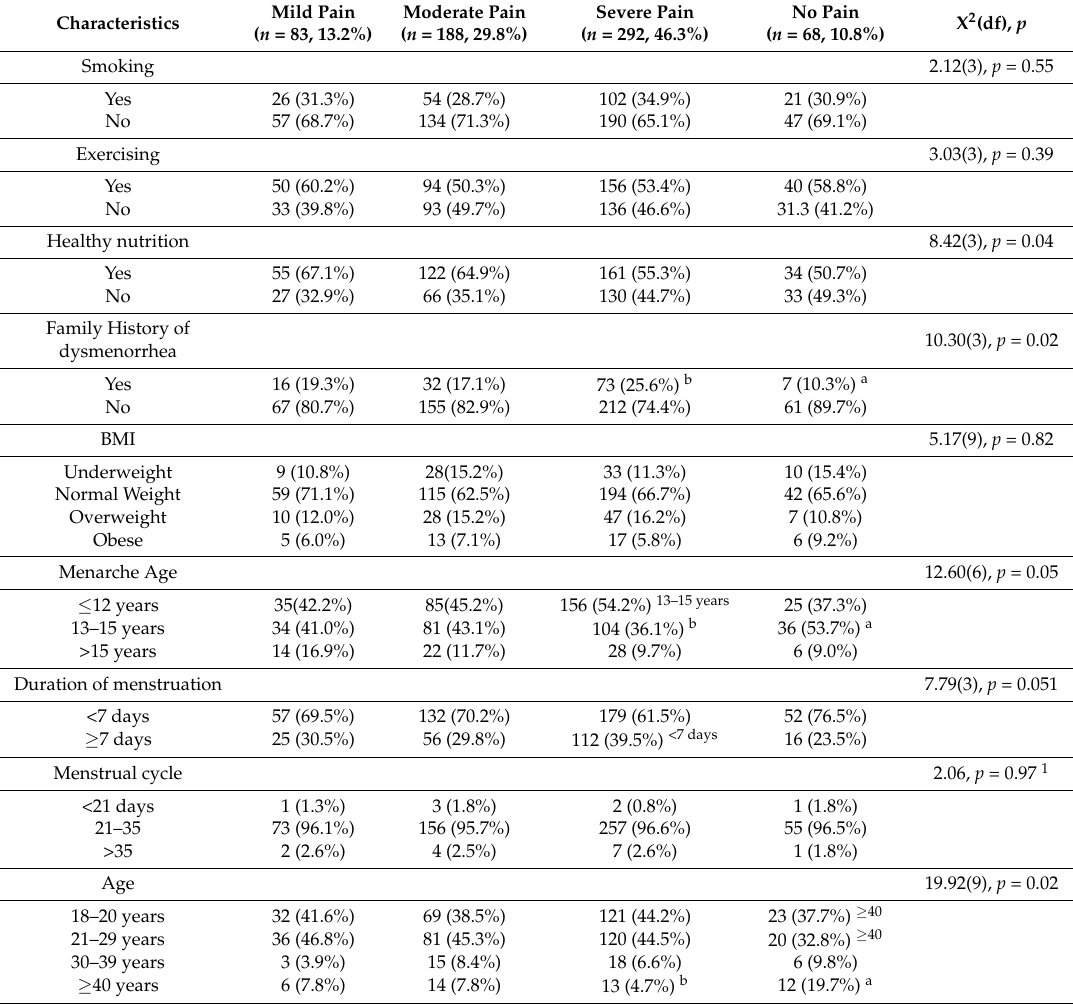
Table 3. The association between dysmenorrhea status and clinical, menstrual